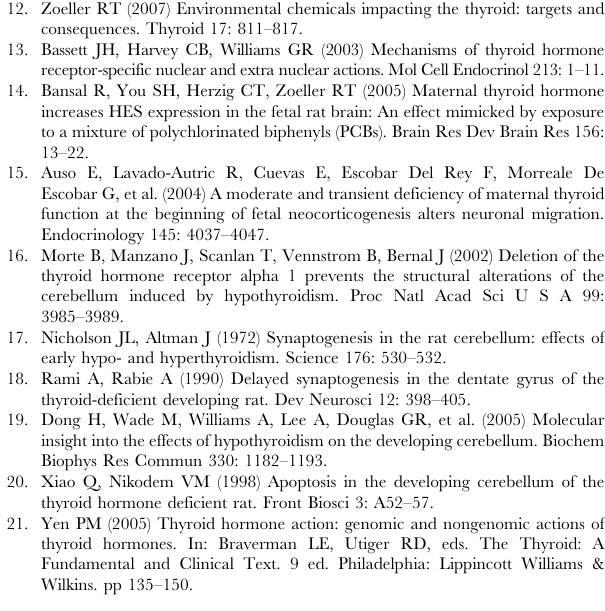
Table S2 Gene expression PCR primers